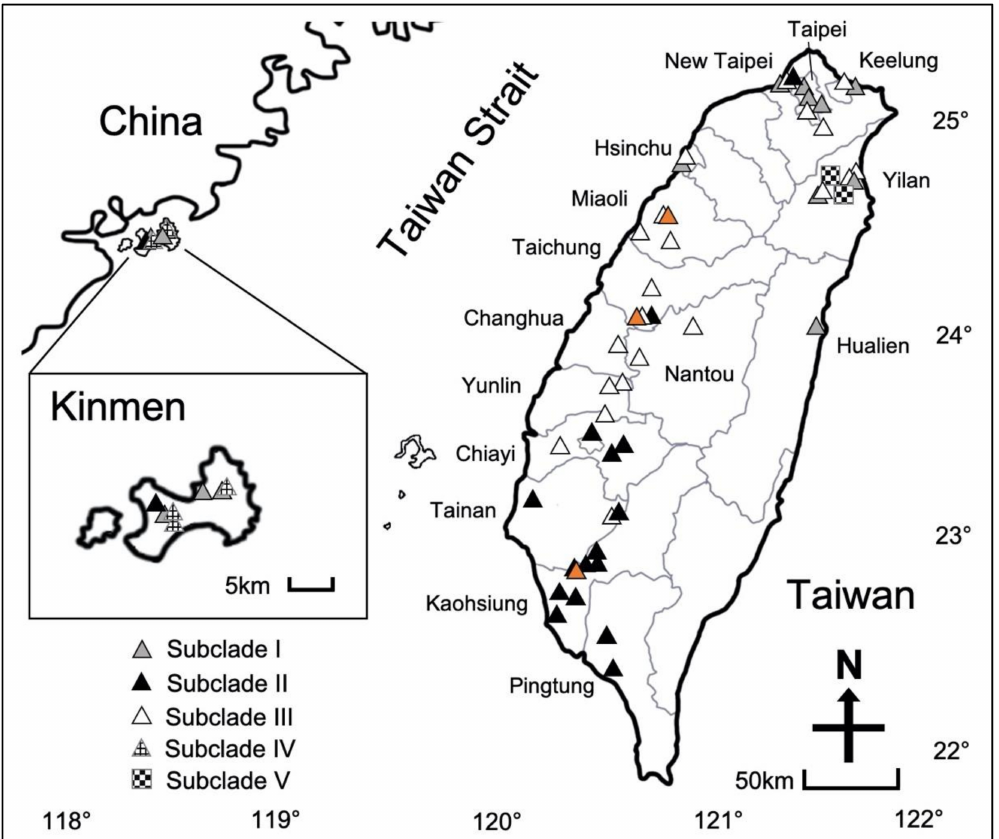
Figure 1. Map showing distributions of collection locality and mitochondrial subclade (I–V) of litchi stink bug (LSB) in both Kinmen and the main island of Taiwan. All county / city names mentioned in the main text are indicated on the map. Orange triangles denote the three sites selected for LSB field